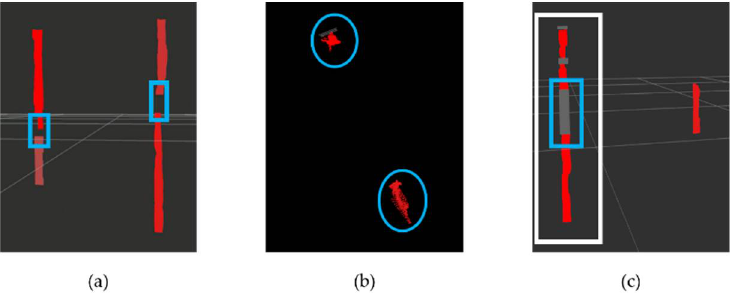
Figure 5. Point cloud clustering strategy based on improved DBSCAN. ( a ) 3D stem point clouds; ( b ) projections of point clouds on the x-z plane; ( c ) stems that split into multiple point clouds clustered into one cluster.